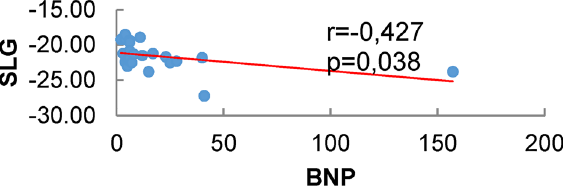
Figure 2. Correlation between SLG and BNP values in patients after liver